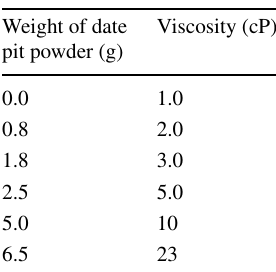
powder on the viscosity of surfactant formulation at 38 °C